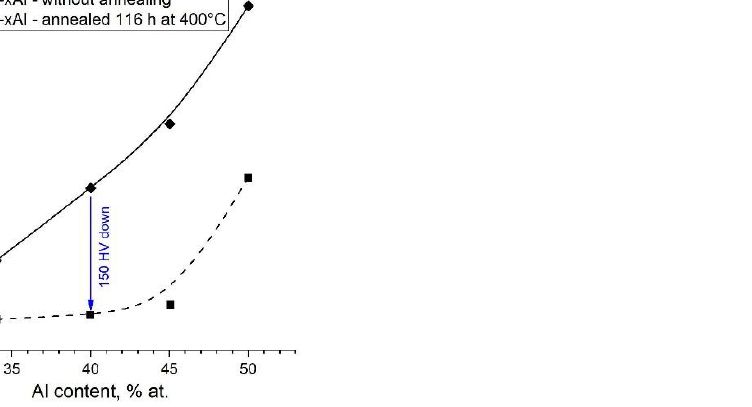
Figure 11. Change in microhardness of samples after annealing to remove thermal vacancies, based on [12].